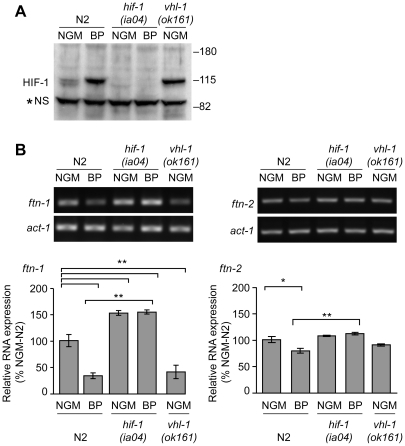
Endogenous ftn-1 and ftn-2 mRNA expression is regulated by HIF-1.(A) N2 wildtype, hif-1(ia04) and vhl-1(ok161) strains were cultured on NGM or NGM-BP, and HIF-1 was detected in extracts by western blots using CeHIF-1 antibodies. *NS, non-specific band. (B) RNA was isolated from the strains in (A) and ftn-1, ftn-2 and actin (act-1) mRNAs were quantified by RT-PCR. Relative changes in ftn-1 and ftn-2 mRNAs are expressed as a percentage of N2 wildtype animals on NGM after normalization to act-1 mRNA. Five (ftn-1) and three (ftn-2) independent experiments were performed and the data are reported as means ± SEM, *p<0.05, **p<0.01.